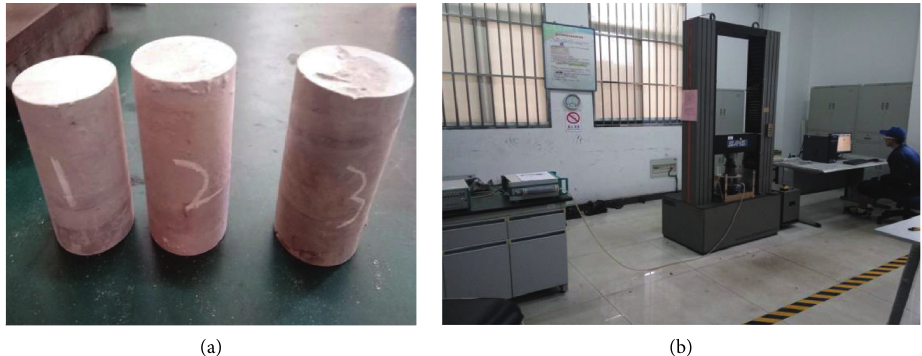
Figure 7: Rock samples preparation and test procedure: (a) mudstone samples and (b) test procedure.